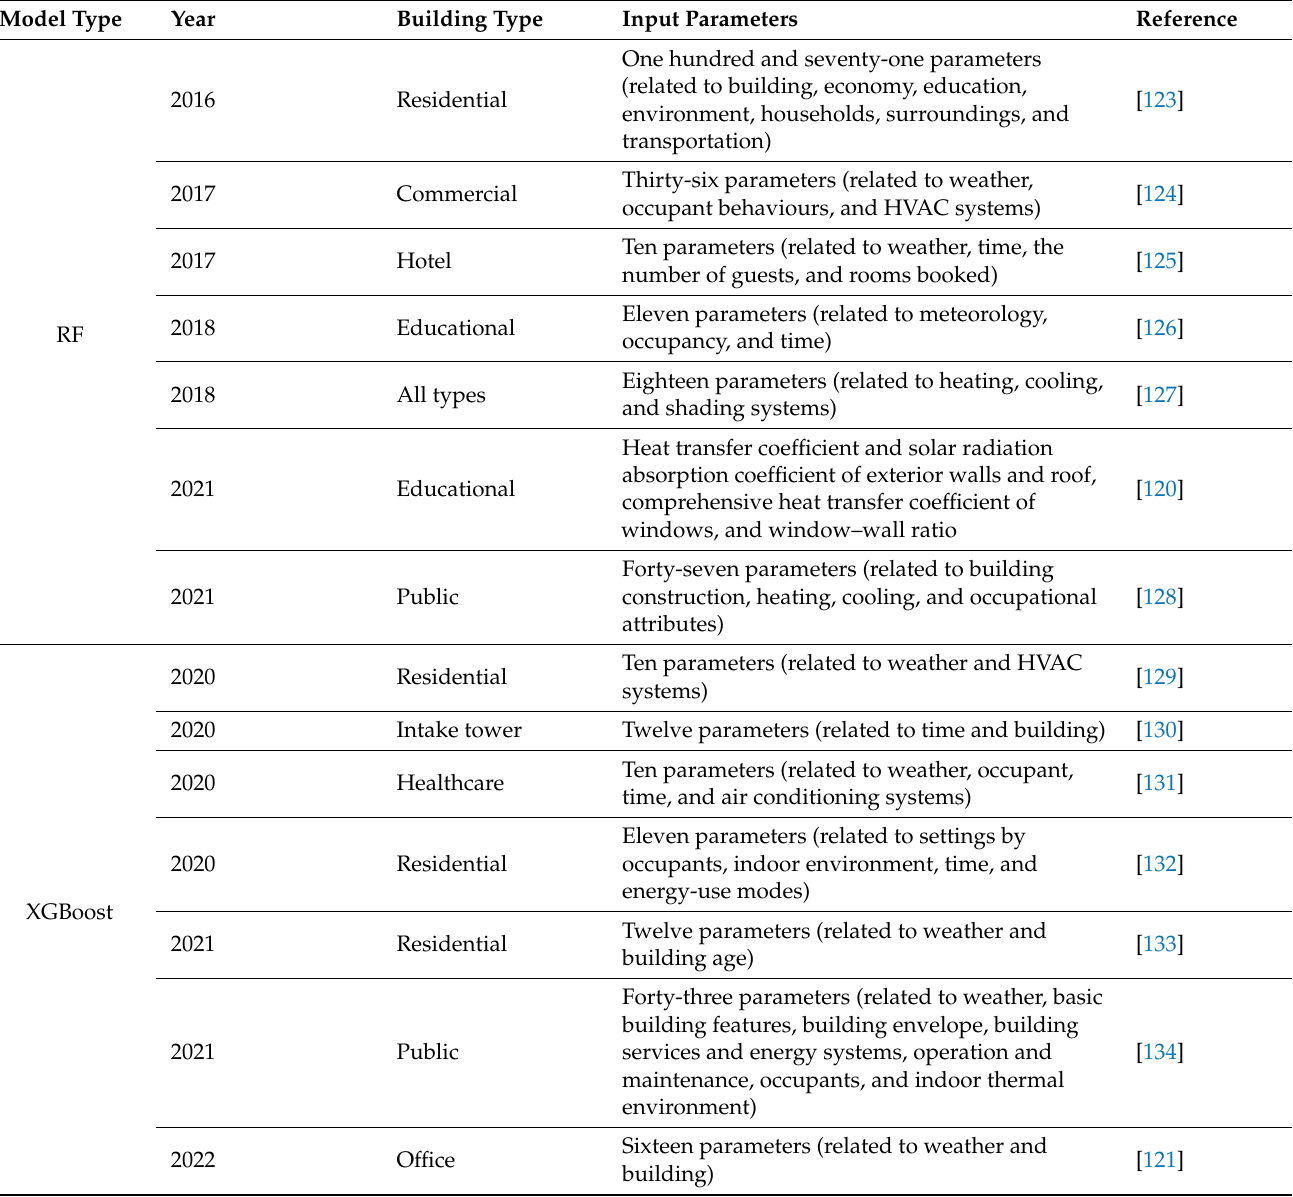
Table 5. Studies related to RF, XGBoost, and RNN